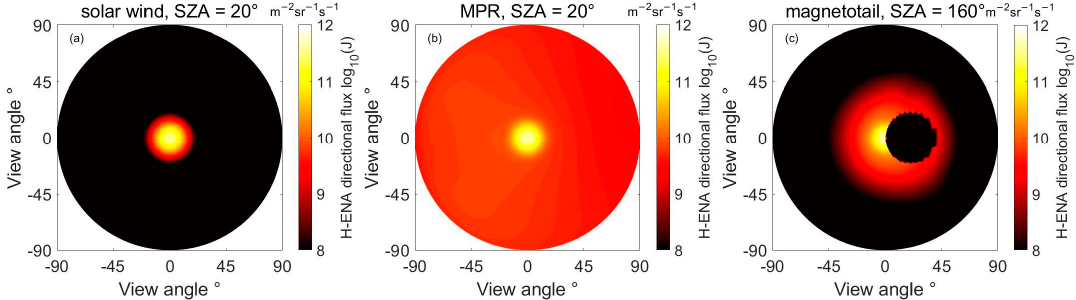
Figure 4. Simulated images of H-ENA directional flux, obtained by a detector located in the ( a ) SW; ( b ) magnetic pileup region (MPR); and ( c ) magnetotail, indicated by virtual positions in Figure 3, respectively. The field of view is 2 π in half space. The color bars are adapted to the logarithmic scale.